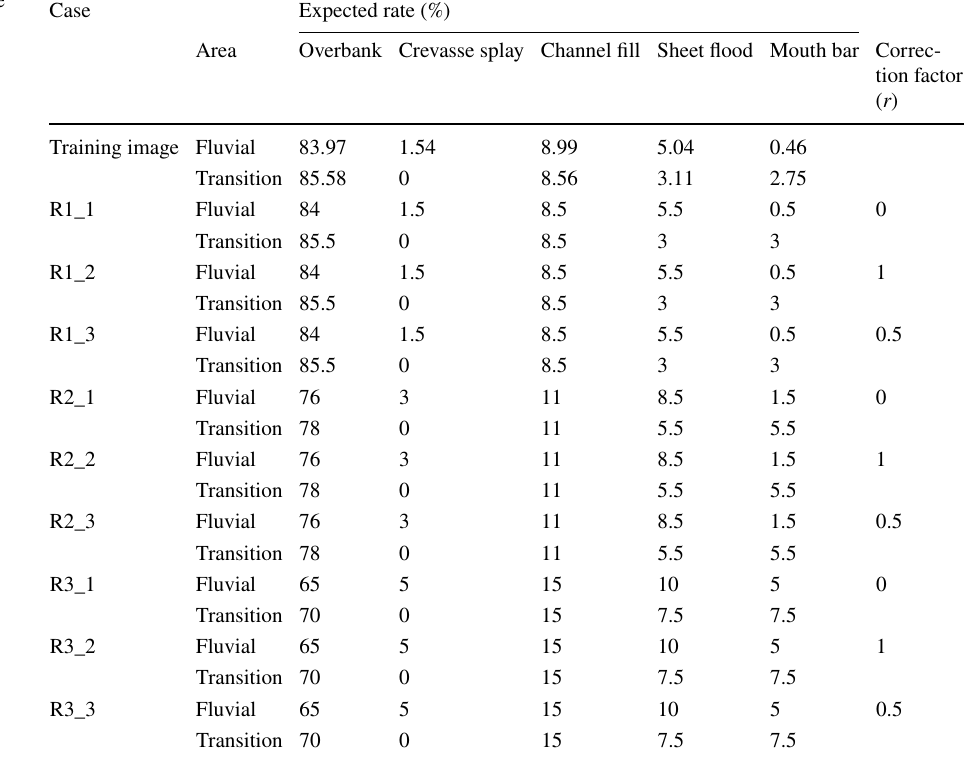
Table 4 Details of expected rate of each facies in each case